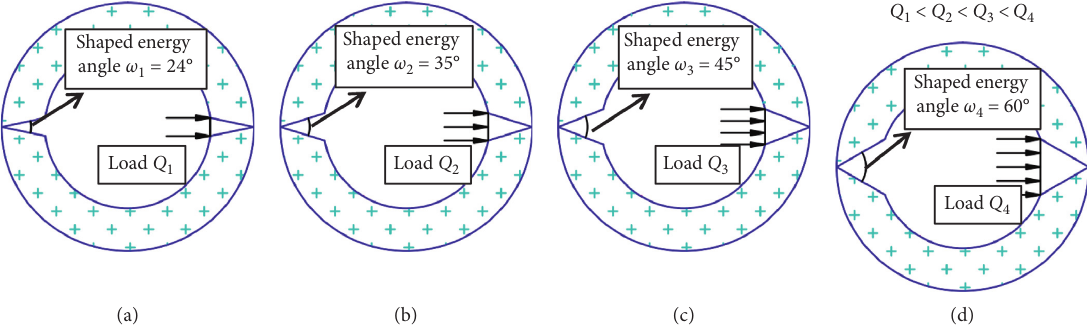
Figure 2: Schematic diagrams of shaped energy angle of bidirectional cumulative tension